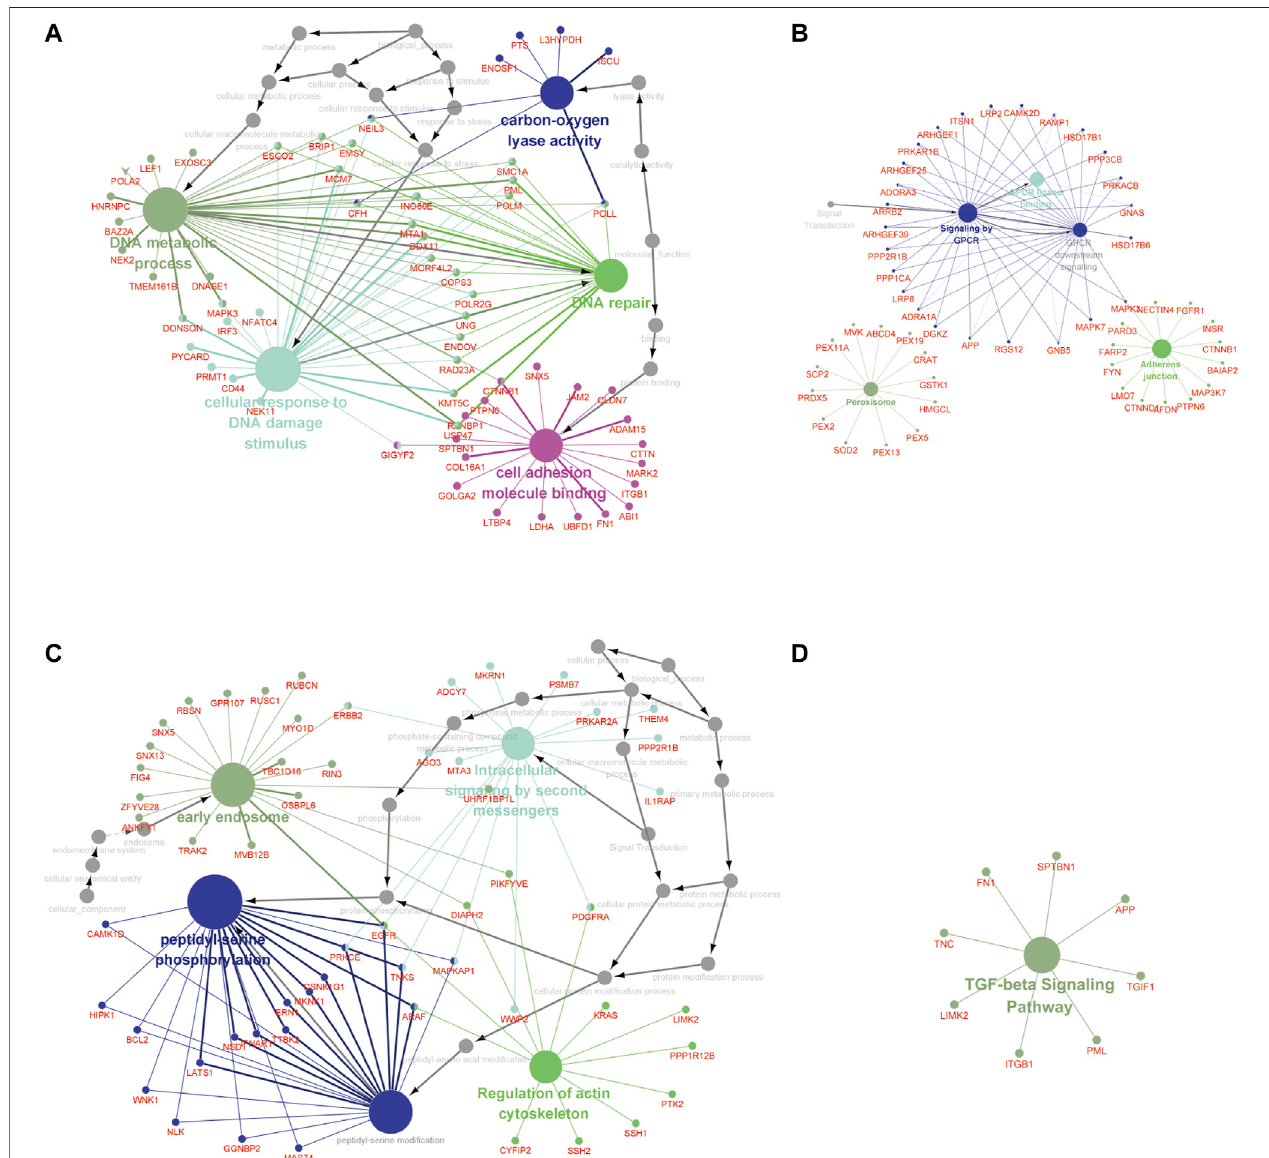
FIGURE4| TheGOtermsand KEGG pathway analyses ofgenesfrom m6A-related ASevents inNCSLC. Thedifferent colorsrepresentthedifferentpathways (A, B) in the regulation network. The GO terms (A) and KEGG pathways enrichment (B) analysis of the m6A-related prognostic AS genes in LUAD. (C, D) The regulation network. The GO terms (C) and KEGG pathways enrichment (D) analysis of the m6A-related prognostic AS genes in LUSC. The KEGG, Kyoto Encyclopedia of Genes and Genomes; GO, Gene Ontology; LUAD, lung adenocarcinoma; LUSC, lung squamous cell carcinoma; AS, alternative splicing.